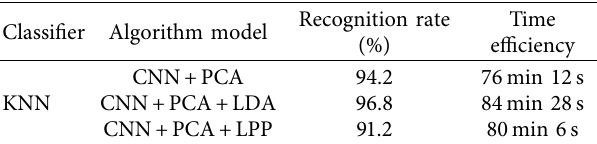
Table 6: Recognition rate and time efficiency of different algorithm models under KNN classifier. Classifier Algorithm